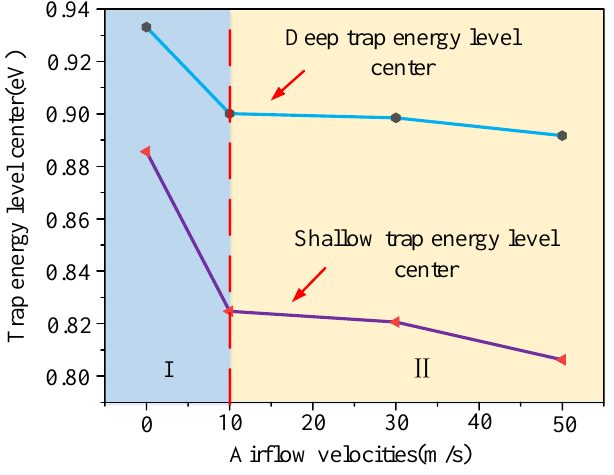
Figure 27. Variation curve of carrier trap energy level center with airflow velocity.